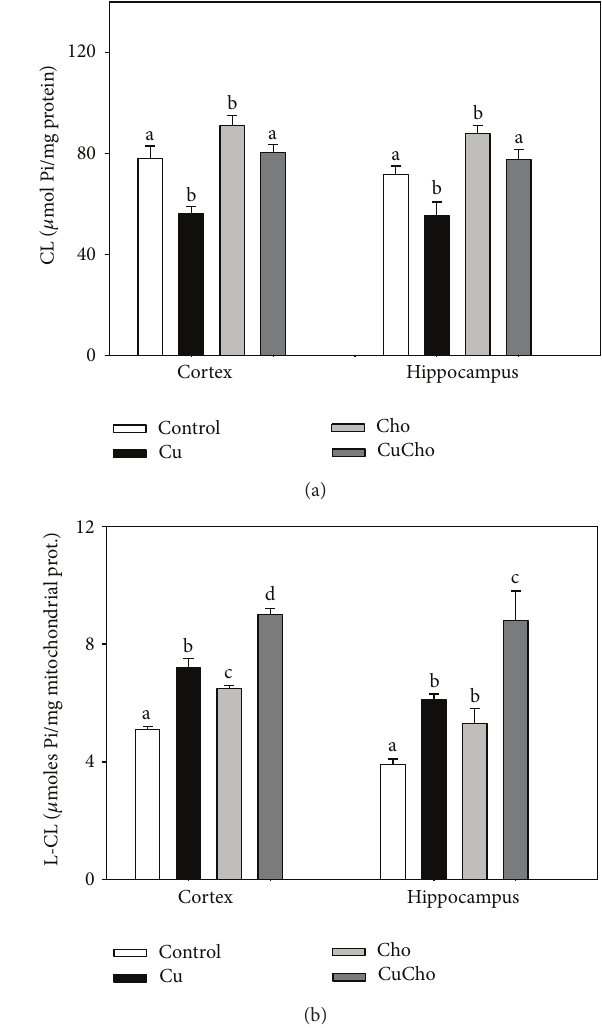
Figure 5: Levels of lipoperoxides (LPOO) (a) and conjugated dienes (b) in mitochondrial fractions from brain cortex and hippocampus. Results are expressed as 𝜇 moles of LPOO/ 𝜇 Moles of Pi in CL, or UDO/mg protein, respectively. Treatments are indicated with dif- ferent colors, control (white bars), Cu (black bars), Cho (gray bars), and CuCho (dark gray bars). Samples were analyzed as indicated in Sections 2.13.1 and 2.13.2. Results are the mean of 10 rats assayed in triplicate ± standard deviation (SD). Significant differences among dataareindicatedwithsuperscriptletters(valueswithdistinctletters are significantly different between them, 𝑃 < 0.01 ).